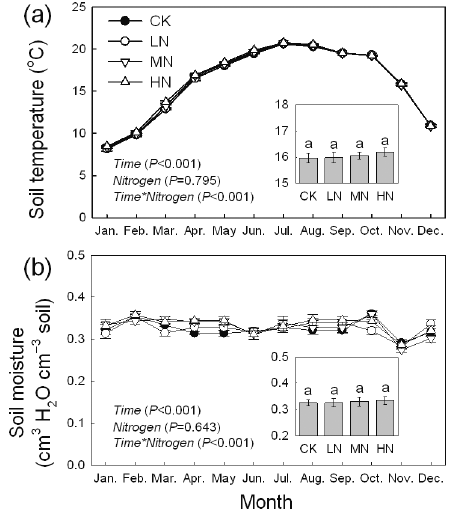
Figure 2. Seasonal variations of soil temperature and soil moisture in a Bambusa pervariabilis 6 Dendrocalamopsis daii plantation from January to December 2009 (mean ± SE, n =3). The treatments were: CK (without N added), LN (50 kg N ha 2 1 year 2 1 ), MN (150 kg N ha 2 1 year 2 1 ), and HN (300 kg N ha 2 1 year 2 1 ) with three replicate plots for each treatment. Monthly applications of NH 4 NO 3 be- gan in January 2008. (a) Soil temperature at 10 cm below surface; (b) volumetric soil moisture in the 0–20 cm soil horizon. Average values of yearly measures were exhibited in the histograms (mean 6 SE, n =3). Results of repeated measures ANOVAs are shown in text. Different letters indicate significant difference among N addition treatments when nitrogen effect is significant ( P , 0.05, Fisher’s least significant difference test).